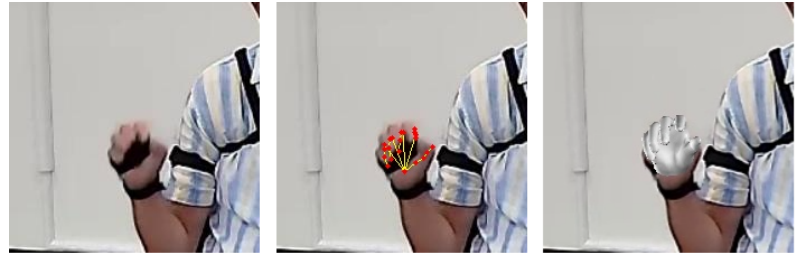
Figure 10. Hand pose estimation with motion blur.